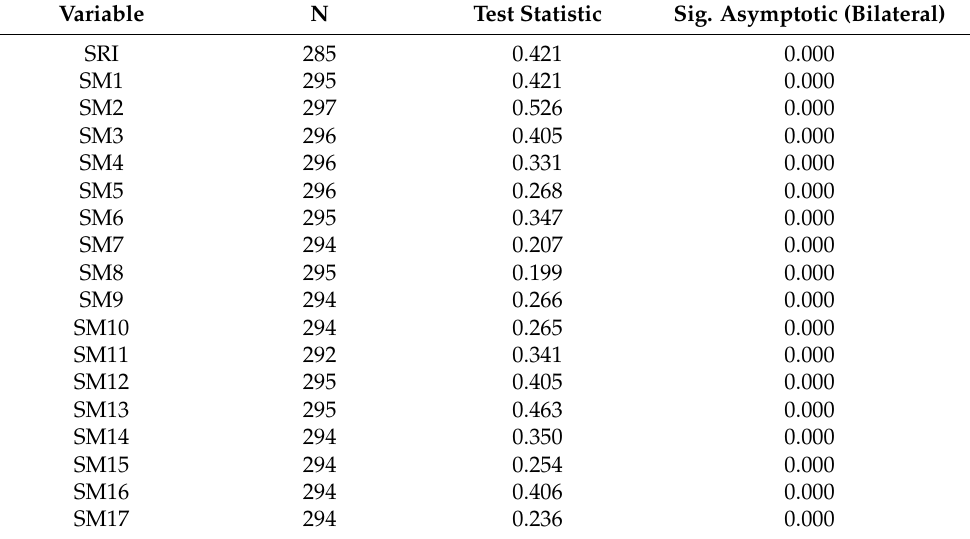
Table 5. Kolmogorov–Smirnov test.